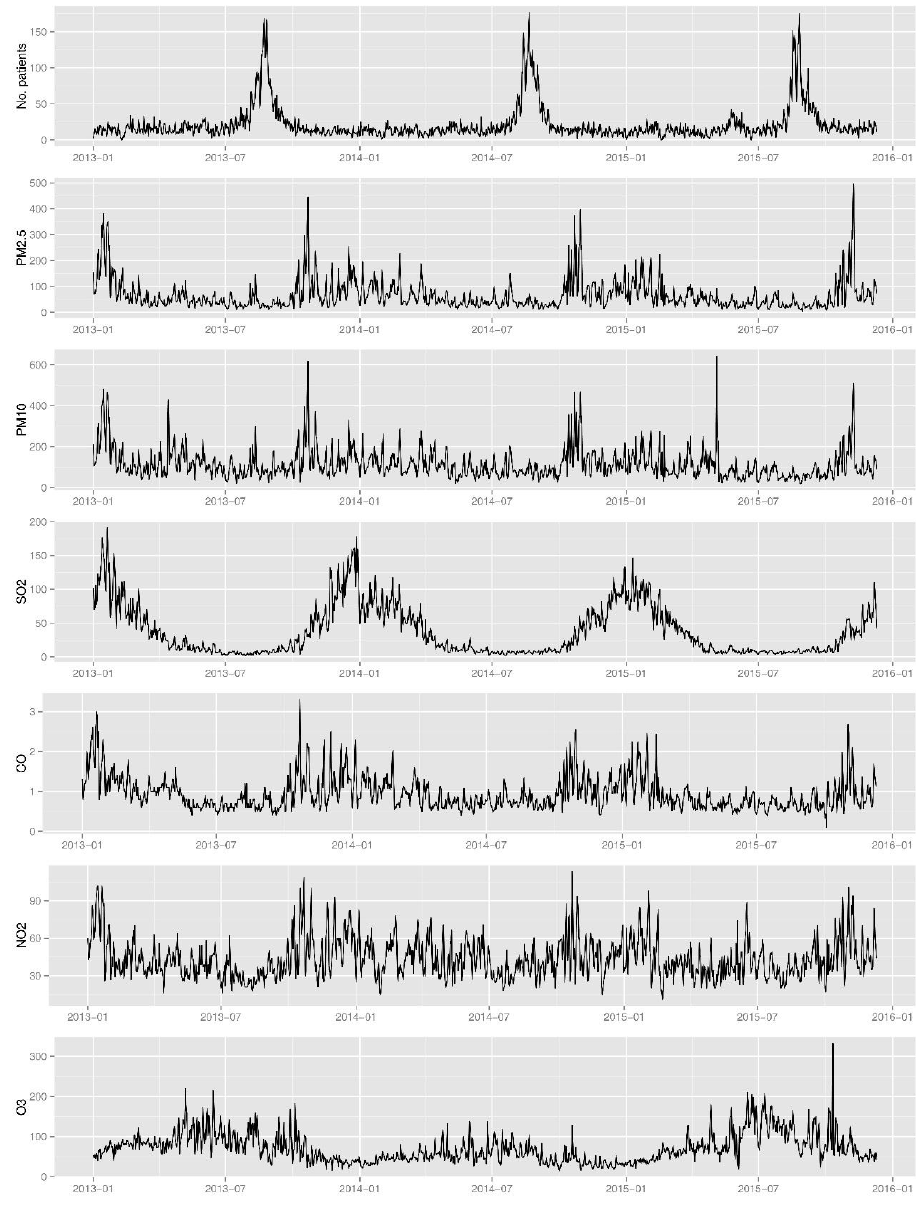
Figure 2. Temporal variations of daily numbers for AR patients and ambient air pollutants (PM 2.5 , PM 10 , SO 2 , CO, NO 2 and O 3 ) in Changchun during 2013–2015.